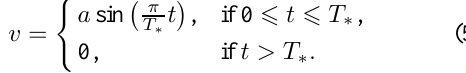
(cid:3) = u (cid:3) =a: (cid:3) ( w (cid:3) ) using the e u u (cid:3) ) = J (cid:3) ( w (cid:3) ) d: 1 ( 0